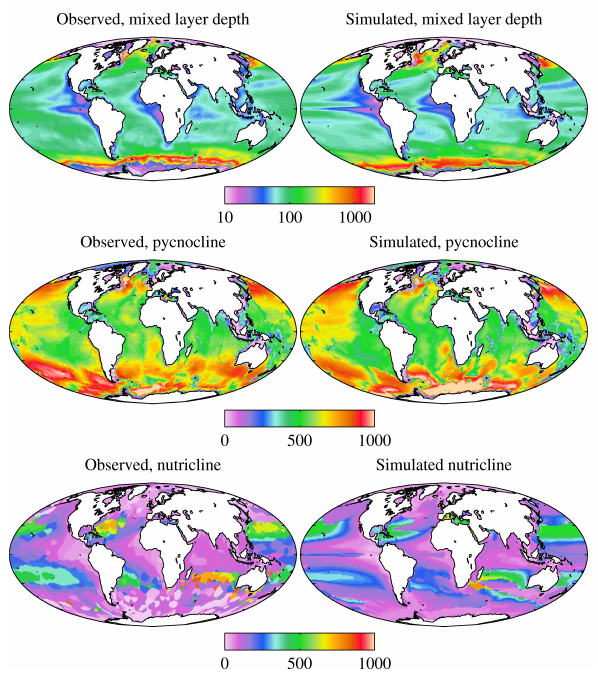
Fig. 5. Observed (left) and simulated (right) annual average mixed layer depth (top), pycnocline depth (middle) and nutricline depth (bottom). Averages based on the period 2000–2009 inclusive. All depths in metres, but note that mixed layer depth is shown on a logarithmic